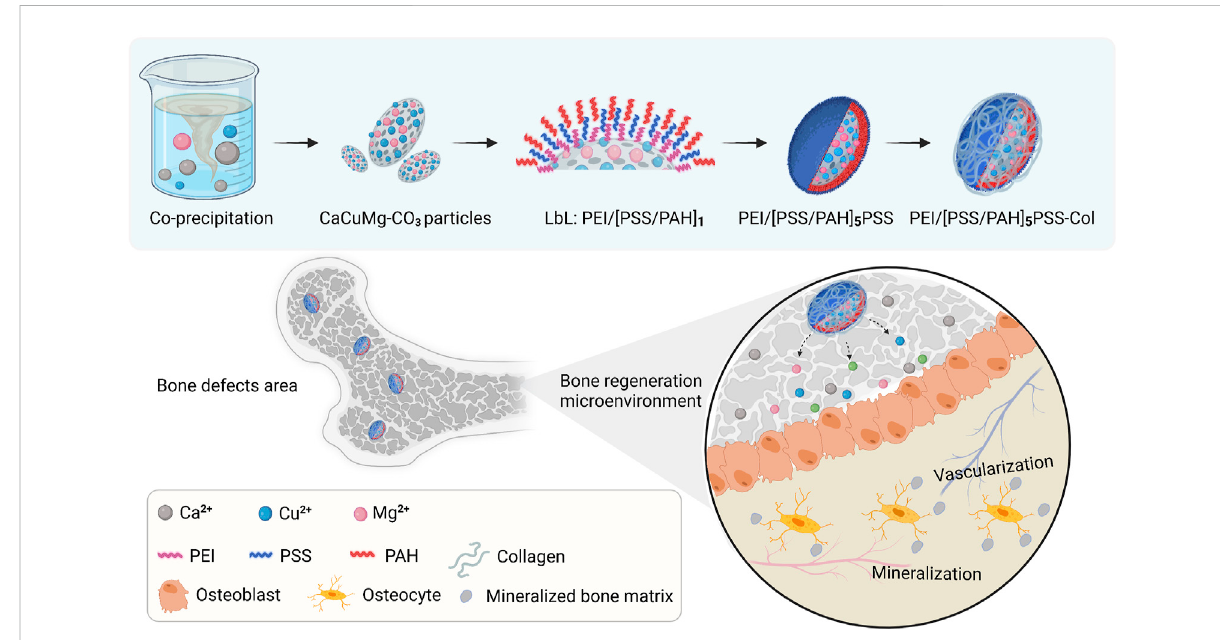
FIGURE 1 Schematicillustration ofthefabrication process ofCaCuMg-PEM-Col microcapsules[CaCuMg-CO 3 particles+ PEI/(PSS/PAH) 5 PSS+ Col],and their effects on bone